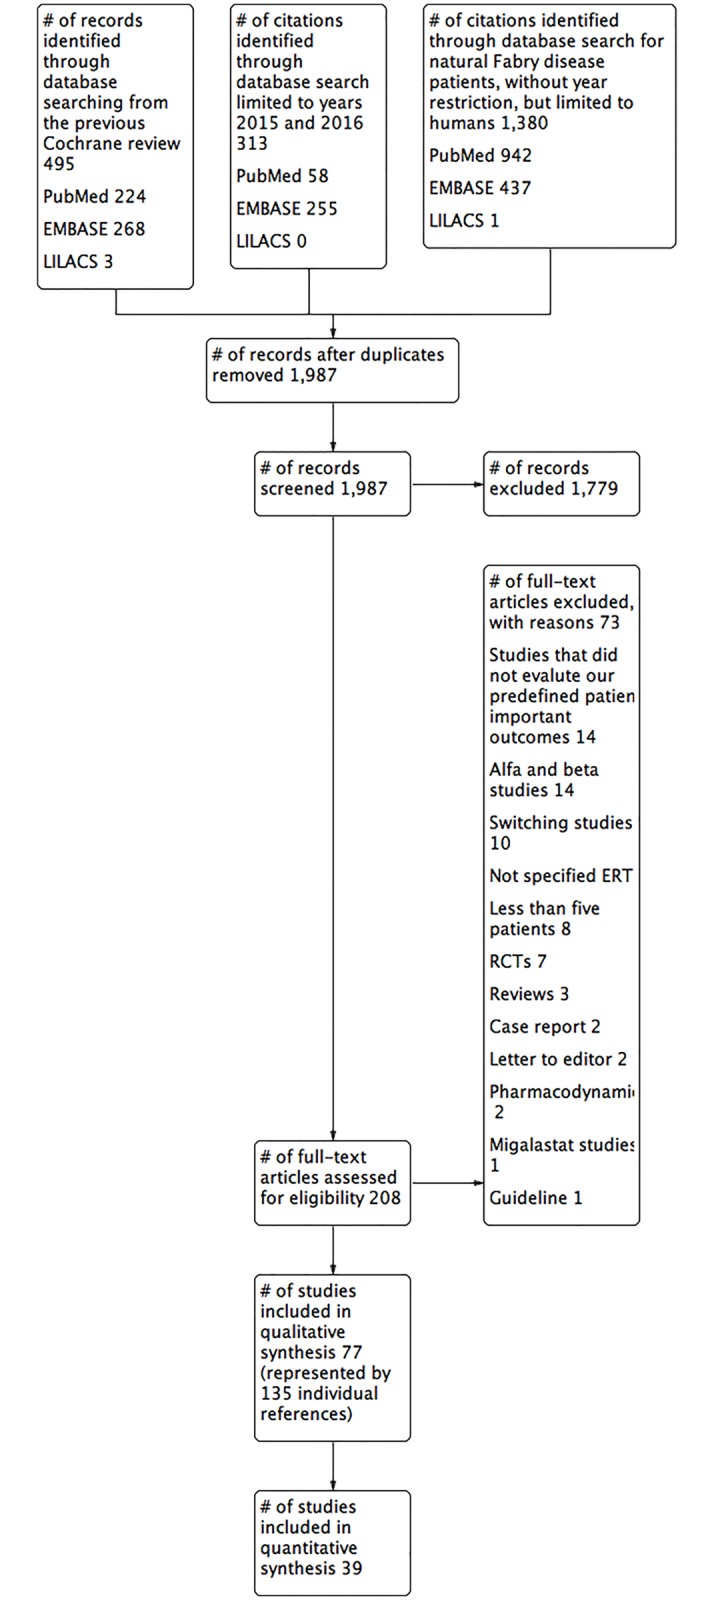
Flowchart of the review.